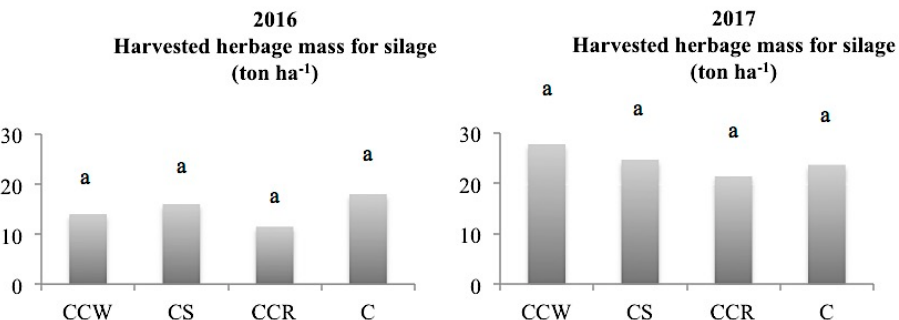
Figure 3. Herbage mass differences ( p < 0.05) of the harvested corn grown alone (C), or interseeded with cowpea (CCW), sunn hemp (CS) or crabgrass (CCR) for silage production. Means within a column for each corn agronomic characteristic without a common superscript differs ( p < 0.05) .